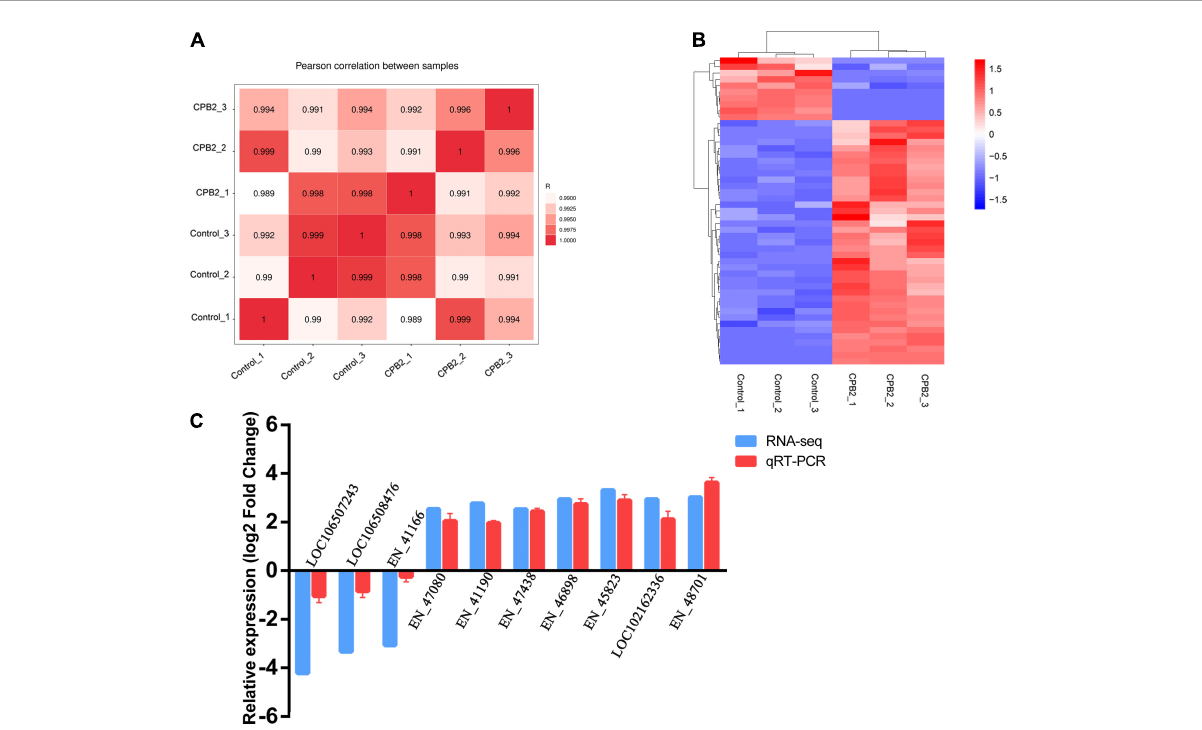
FIGURE1 Quality analysis of the RNA-seq data. (A) Chart of the expression correlation between samples. R is Pearson’s correlation coefficient. (B) A hierarchical heat map of differential long non-coding RNAs (lncRNAs) in the control and toxin-treated intestinal porcine epithelial cell line-J2 (IPEC-J2) cells. Data are expressed as the fragments per kilobase of transcript per million mapped reads. Different colors indicate different levels of gene expression, with colors ranging from blue through white to red indicating low to high expression. (C) Quantitative real-time reverse transcription polymerase chain reaction (qRT-PCR) validation of 10 differentially expressed